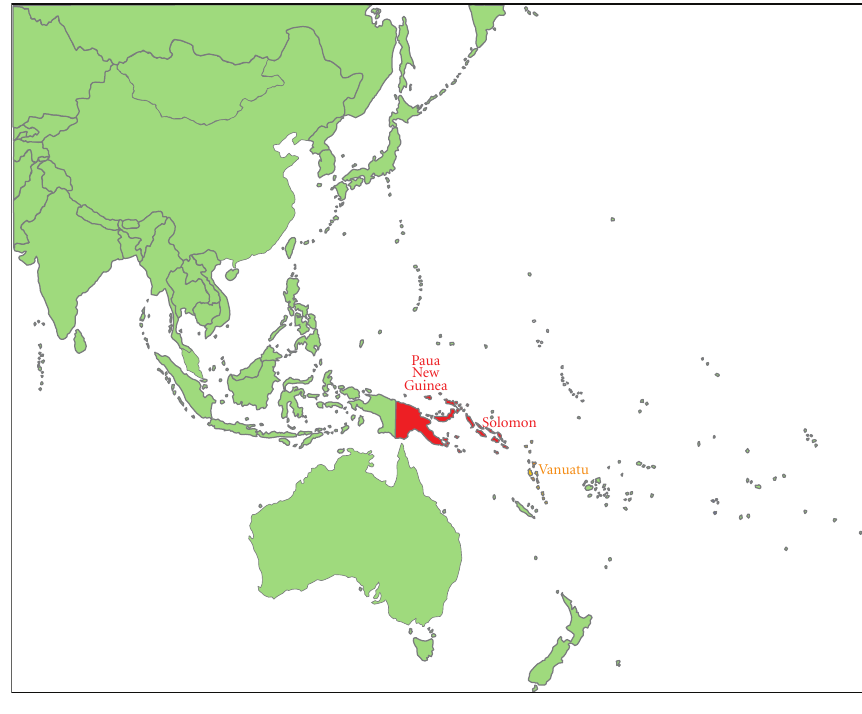
Figure 4: Yaws prevalence in the Western Pacific Region in the